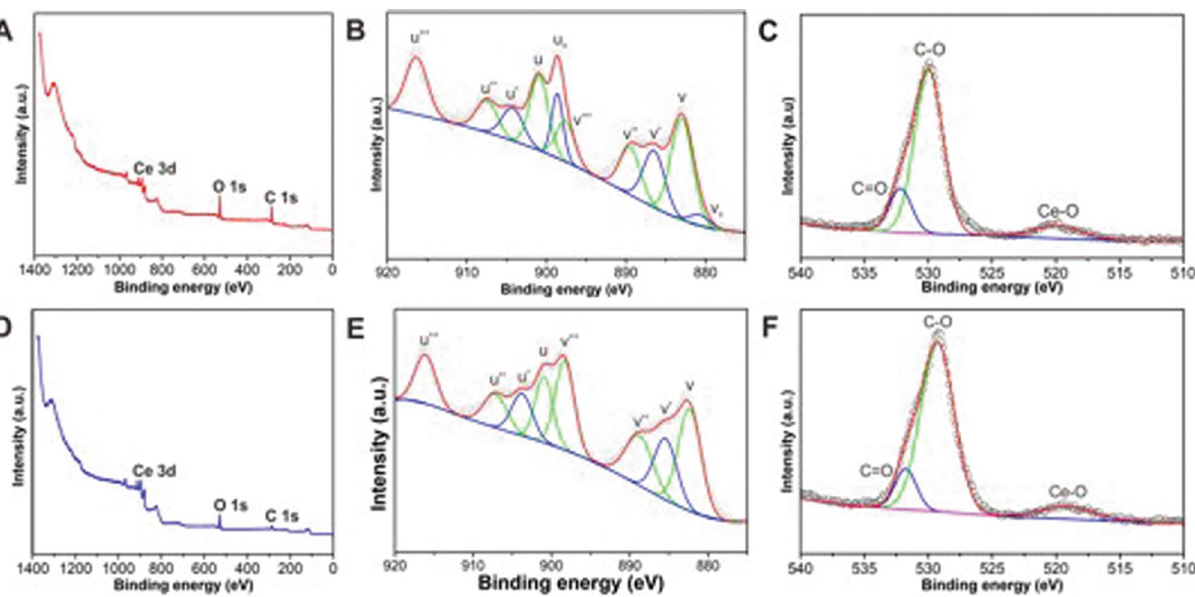
Figure 2. XPS survey spectra ( A , D ), XPS high-resolution binding energy spectra of Ce 3 d ( B , E ) and O 1 s ( C , F ) of Ceria NRs and Ceria NSs, respectively. Ce 4+ and Ce 3+ were coexistence in Ceria NRs and Ceria